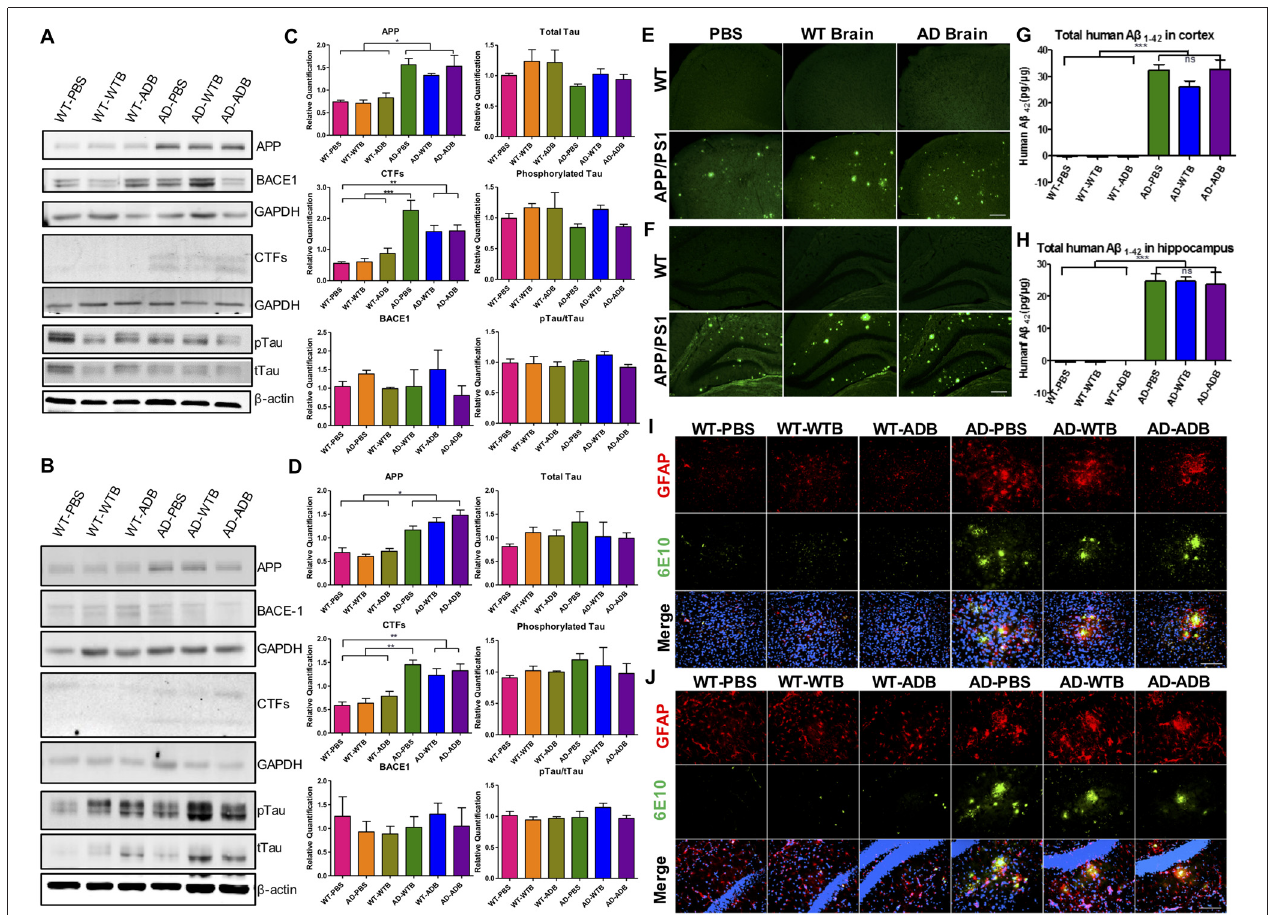
FIGURE 7 | A β load and neuroinflammation in 11-month-old mice with gavage. The depicted western blot indicates the expression levels of amyloid precursor protein (APP), β secretase (BACE1), C-terminal fragments (CTFs), total Tau and phosphorylated Tau in the cortex (A) and hippocampus (B) of 11-month-old mice with different treatments at the age of 6 months old. The relative expression levels of proteins in the cortex (C) and hippocampus (D) were shown in the diagram ( n = 3–5 for APP and CTFs and n = 3 for BACE1). GAPDH or β -actin served as the internal control. The A β load and amyloid plaques in the cortex (E) and hippocampus (F) of transgenic AD and WT mice were stained with Thioflavin S. The toxic A β 1–42 level in cortex (G) and hippocampus (H) were examined with the ELISA assay. Representative fluorescent images of glial fibrillary acidic protein (GFAP; red), A β (green) and merged with 4 (cid:48) ,6-diamidino-2-phenylindole DAPI; blue) for the cortex (I) and hippocampus (J) of the indicated mouse strains with three different treatments were depicted. The astrocytes marked by GFAP expression were morphologically activated in the transgenic mice but had no difference among three treatments. Scale bar: 100 µ m. All data were analyzed with one-way